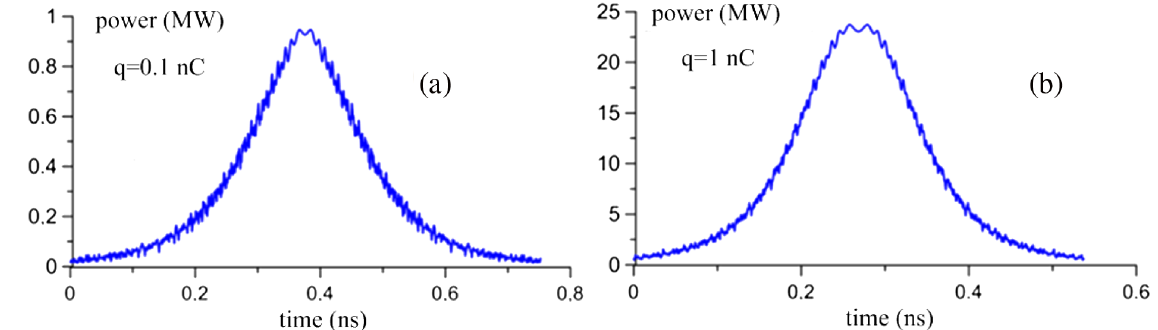
¼ λ = 4 ) bunches with two different bunch charges 0.1 (a) and 1 nC (b). The wave bunch.FIG. 10. Spontaneous emission from short ( L e; 0 pulse (power versus time) radiated in the group resonance